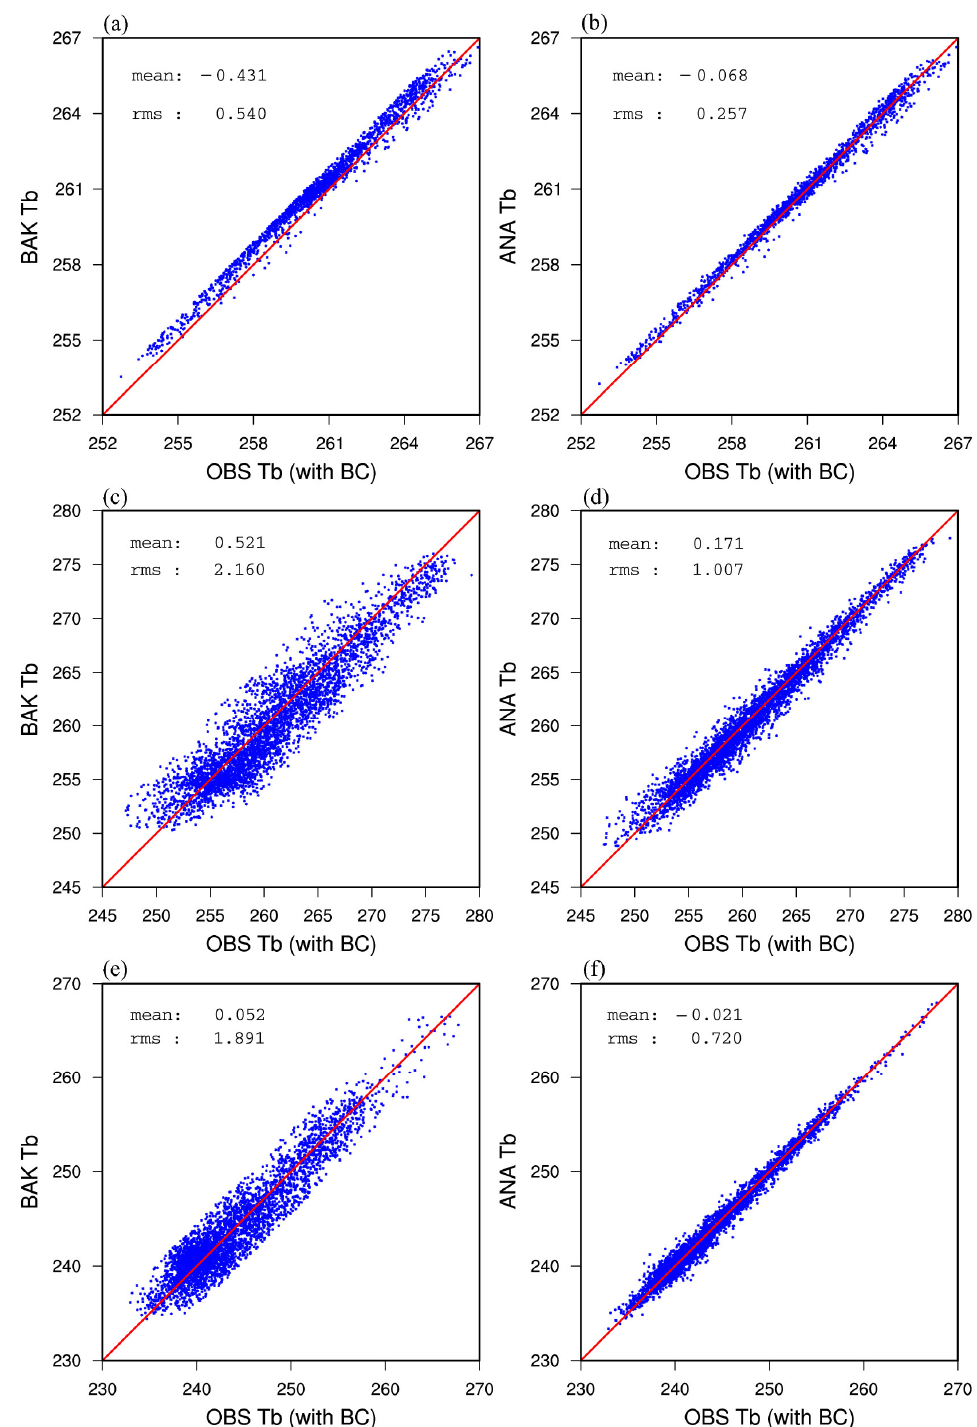
Figure 3. Scatters of ( a , c , e ) background fields and ( b , d , f ) analysis fields after bias correction at 0600UTC on 22 July 2018, with NOAA-19 AMSUA channel 5 in the upper row, NOAA-19 MHS channel 4 in the middle row, and FY-3D MWHS2 channel 11 in the lower row.